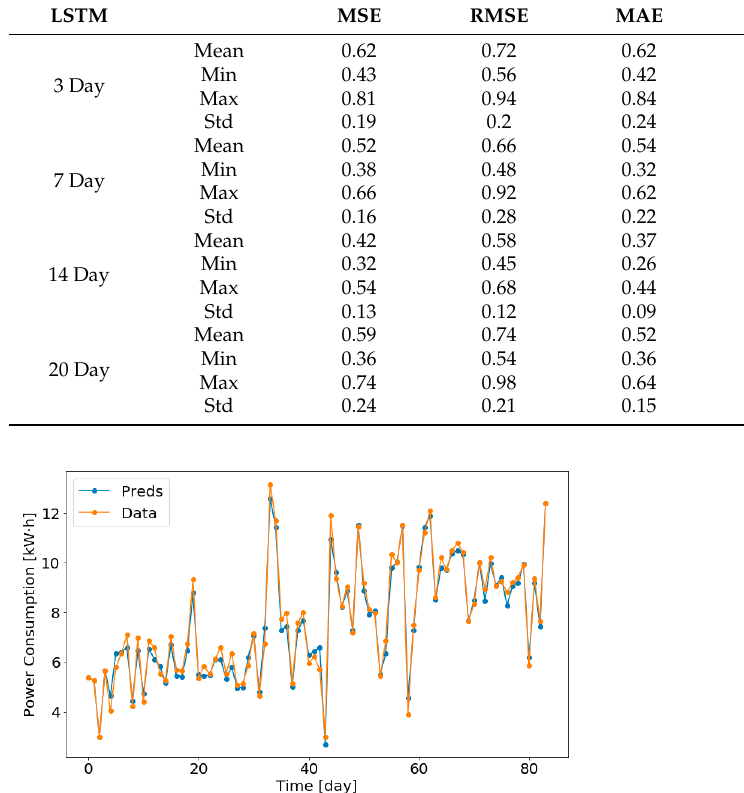
Table 2. Prediction accuracy of LSTM under different windows.